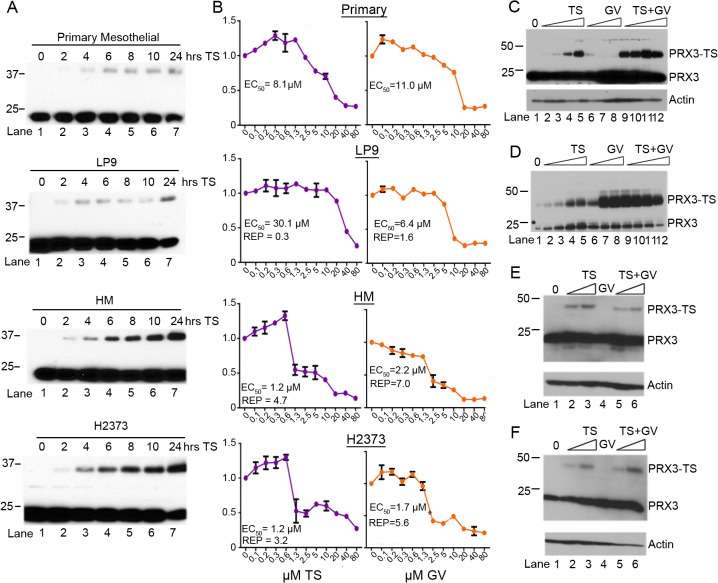
Adduction of PRX3 by TS correlates with cytotoxicity.(A) Human primary mesothelial, immortalized LP9 mesothelial, and HM and H2373 mesothelioma cell lines were incubated with 5 μM TS and lysates were collected at indicated time points over 24 hr. Formation of TS induced PRX3 dimers was visualized by reducing SDS-PAGE and immunoblotting with anti-PRX3 antibody. (B) Cell lines from (A) were incubated with indicated concentrations of TS (left) or GV (right) for 24 hr and total cell mass was determined by staining with crystal violet (Y axis values were normalized to untreated cells). The EC50 values for the indicated cell lines to TS or GV and the relative potency (REP) of TS and GV, as compared to primary mesothelial cells, are shown. (C) HM cells were treated with increasing concentrations of TS, GV, or TS + GV for 18 hr and extracts were resolved by reducing SDS-PAGE. PRX3 modification was assessed by immunoblotting as before. Note that GV accentuates modification of PRX3 by TS by blocking the activity of TRX2. (D) Extracts from cells treated as in panel C were resolved by non-reducing SDS-PAGE and PRX3 monomers (~23 kD) and disulfide-bonded dimers (~46 kD) were assessed by immunoblotting for PRX3. Note that GV markedly increased the level of disulfide-bonded PRX3 dimers, an indication of severe mitochondrial oxidative stress. (E) HMC2 and (F) HMC3 human primary mesothelial cell cultures were incubated with increasing doses of TS, GV or TS + GV for 18 hours, and assessed for PRX3 expression after reducing SDS-PAGE by immunoblotting. The formation of the modified species of PRX3 in response to TS was less evident in primary mesothelial cells.